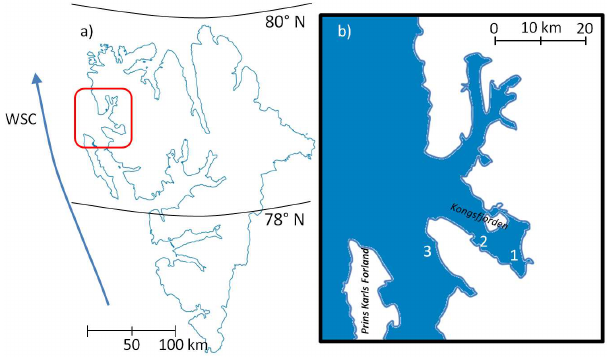
Fig. 1. (a) Overview map of the investigation area (marked red). Blue arrow indicates the direction of the West Spitsbergen Current (WSC). (b) Sampling locations. Point 1: close to the glacier, Point 2: marine laboratory with deep sea water inlet in Ny- ˚Alesund, Point 3: fjord mouth (outside of